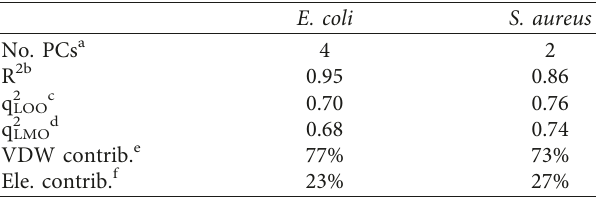
Table 2: Statistical parameters of the 3D-QSAR models for the antibacterial activity against E. coli and S . aureus .